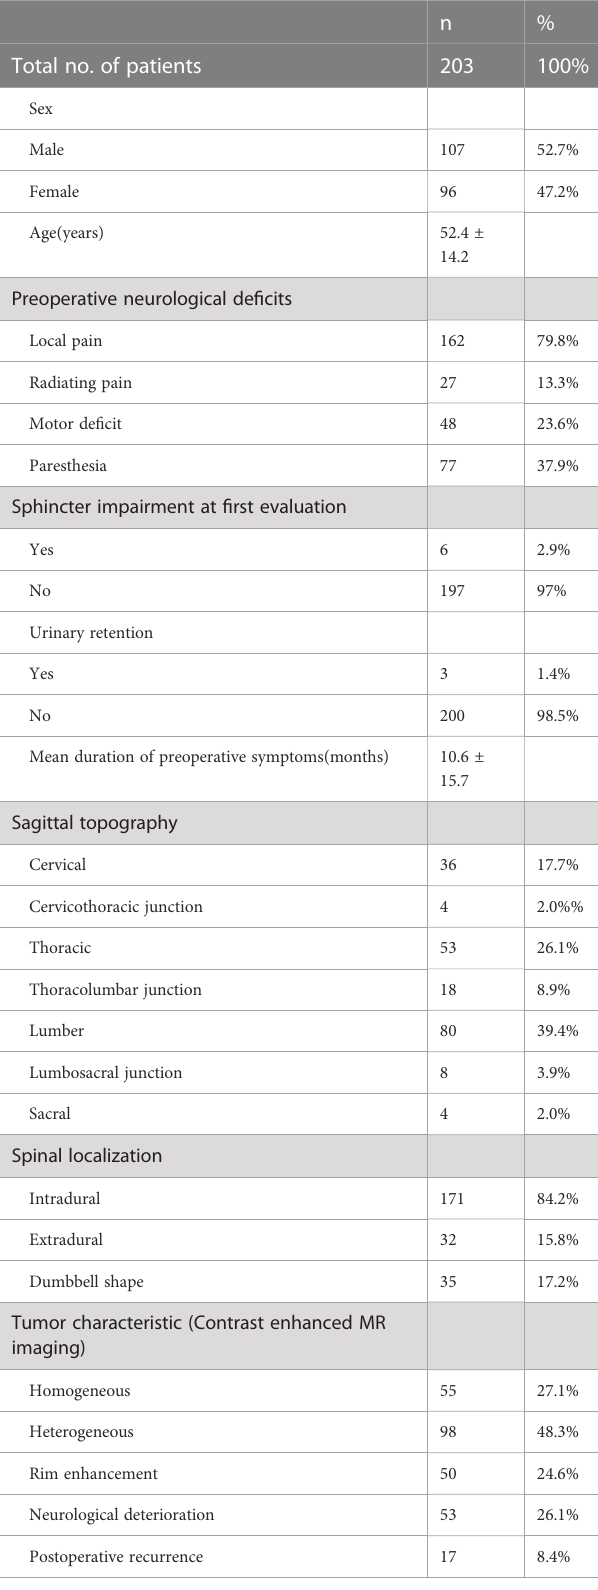
TABLE 1 Baseline data and clinical presentation.